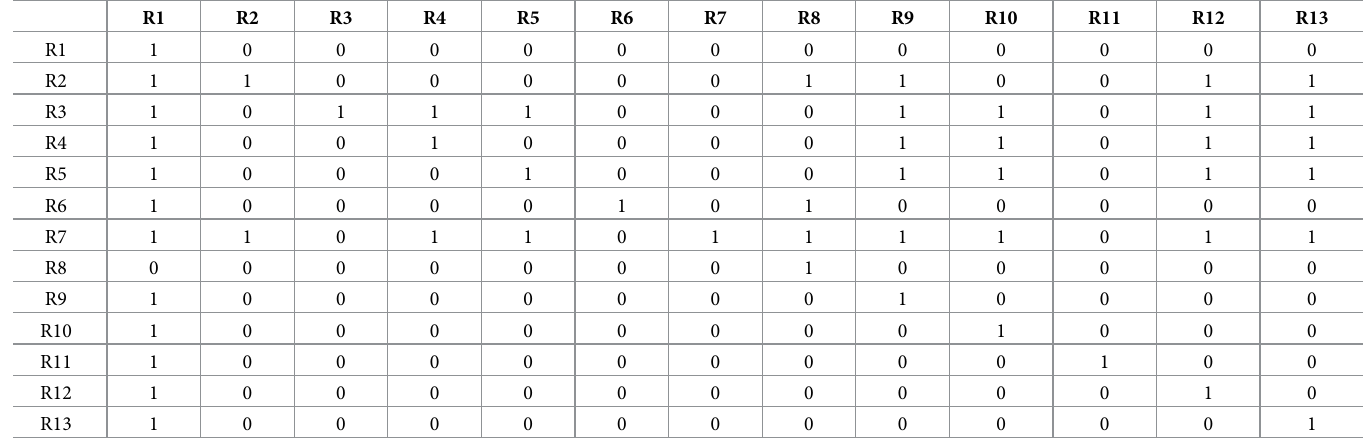
Table 3. Reachability